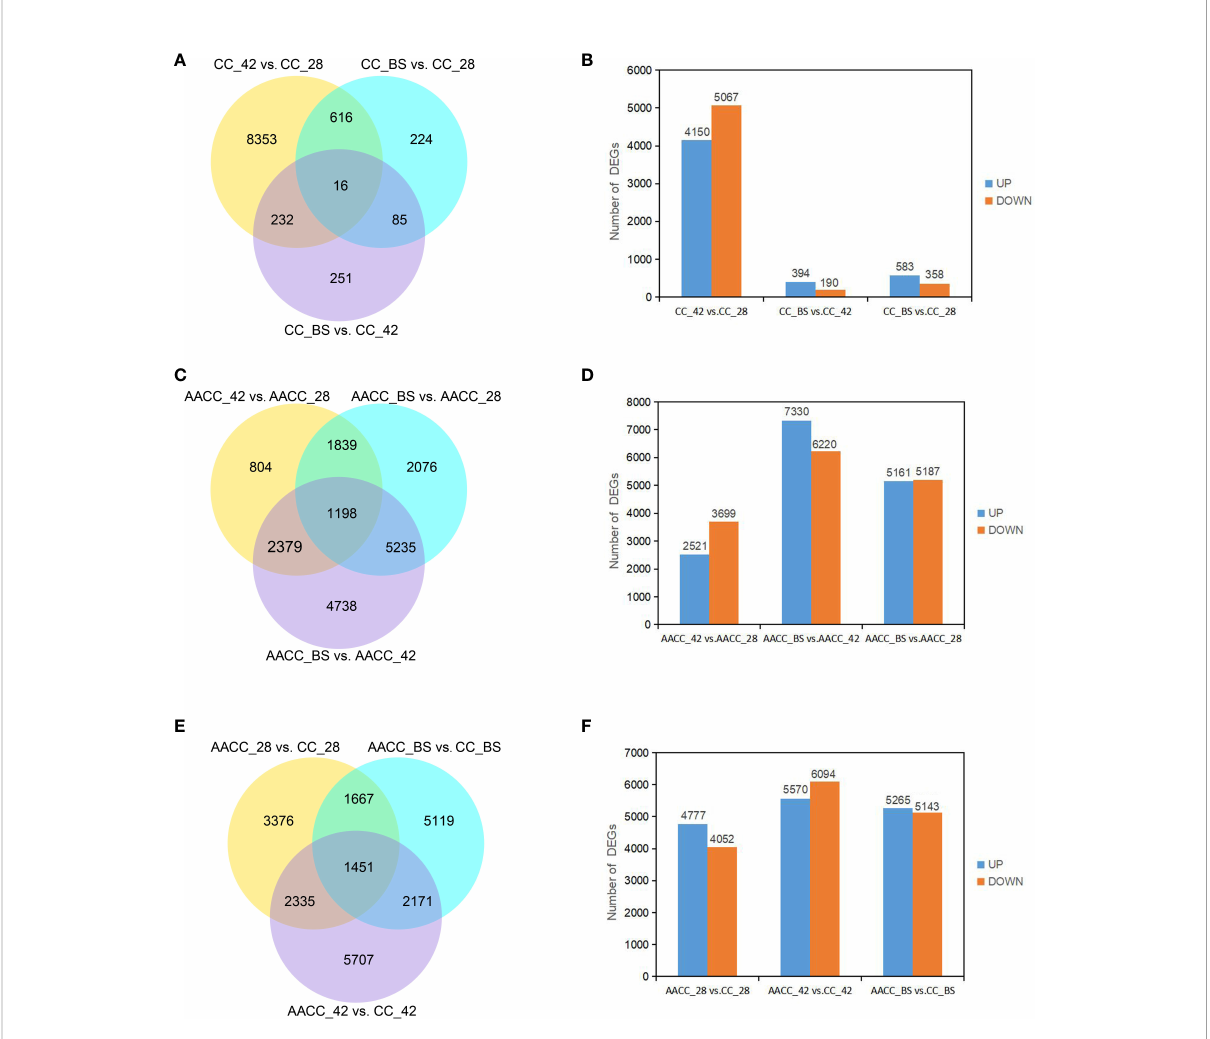
FIGURE 3 DEGs identi fi ed by pairwise comparisons of the stem transcriptomes in the stems of (CC) and its AACC. (A) Venn diagram of DEGs in CC. (B) Pairwise comparison of stem gene expression at three stages of CC. The number of up-regulated and down-regulated genes in each pair of developmental stages. (C) Venn diagram of DEGs in AACC. (D) Pairwise comparison of stem gene expression in three stages of AACC. The number of up-regulated and down-regulated genes in each pair of developmental stages. (E) Venn diagrams of DEGs between CC and AACC at the particular stage. (F) Up-regulation and down-regulation of DEGs expression in CC and AACC at corresponding